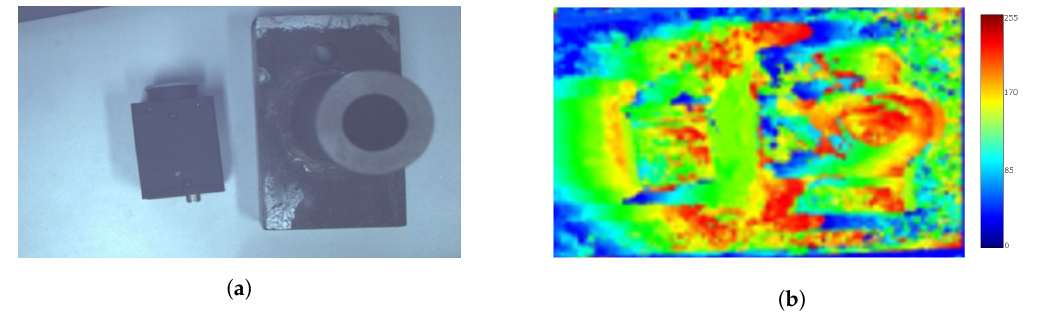
Figure 6. Height estimation using kinematic stereo method—preliminary test. ( a ) The image prior to processing containing two objects of different heights. ( b ) The height disparity map produced using the optical flow algorithm on the first